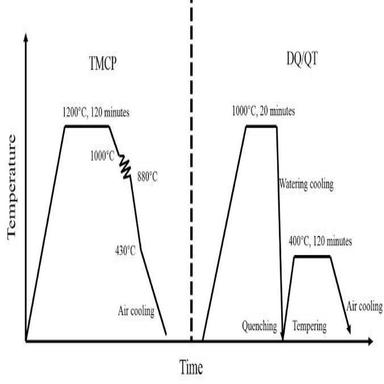
Schematic of test steel preparation.